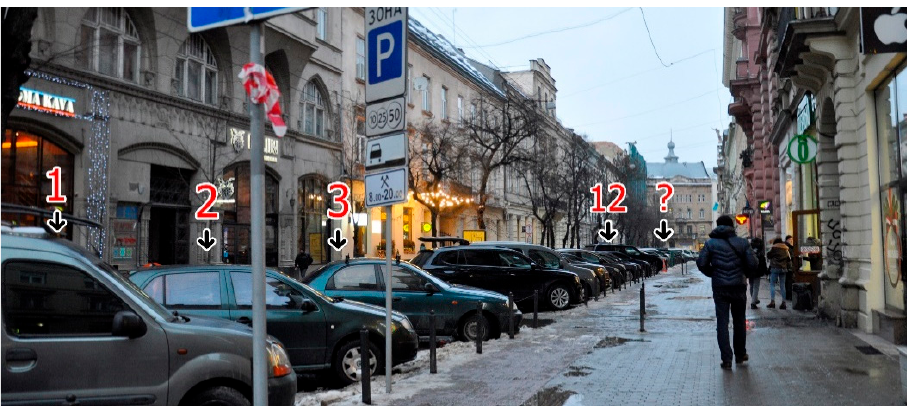
Figure 10. According to the official data on Sichovykh Striltsiv Street there are only 12 on-street parking places (LCC website [52]). Photo by R. Liubytskyi.